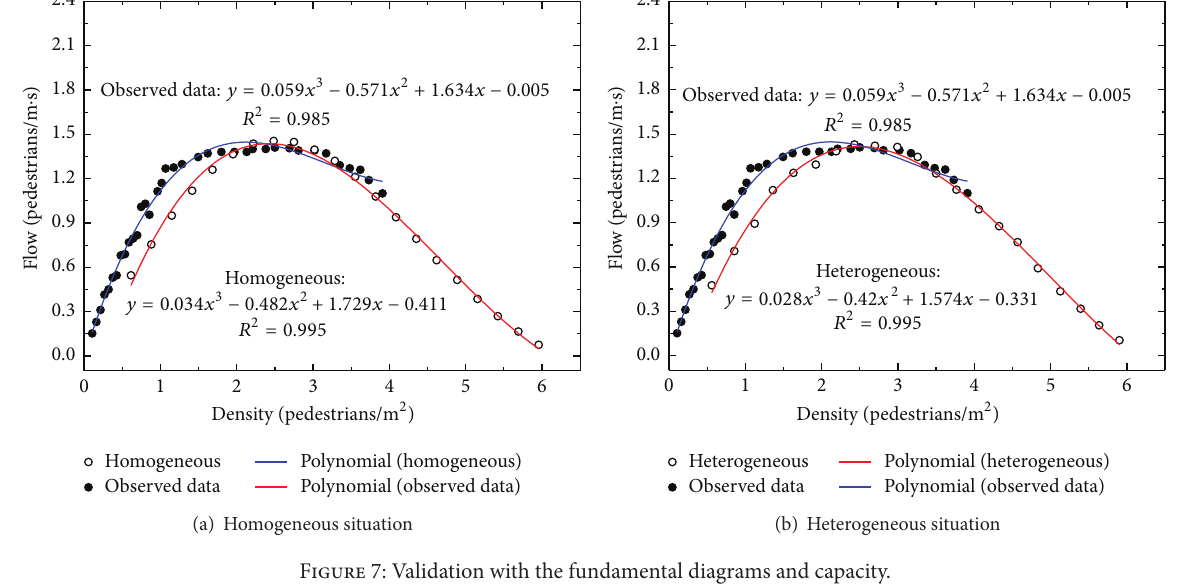
Figure 7: Validation with the fundamental diagrams and capacity.